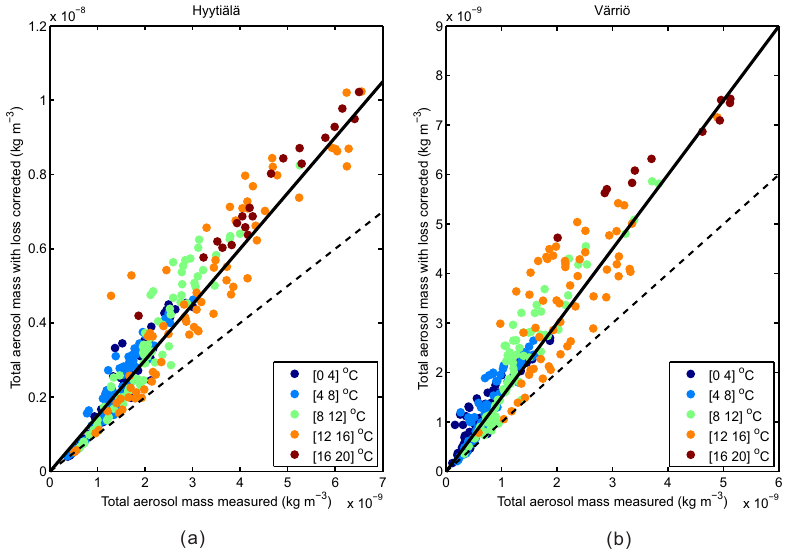
Figure 7. Total aerosol masses with deposition loss corrected vs. aerosol masses “observed” at (a) the SMEAR II station, and (b) at the SMEAR I station. The marker colours of legends represent the same binned temperatures. The dashed line indicates 1 : 1 ratio, and the solid line is the 1 . 5 : 1